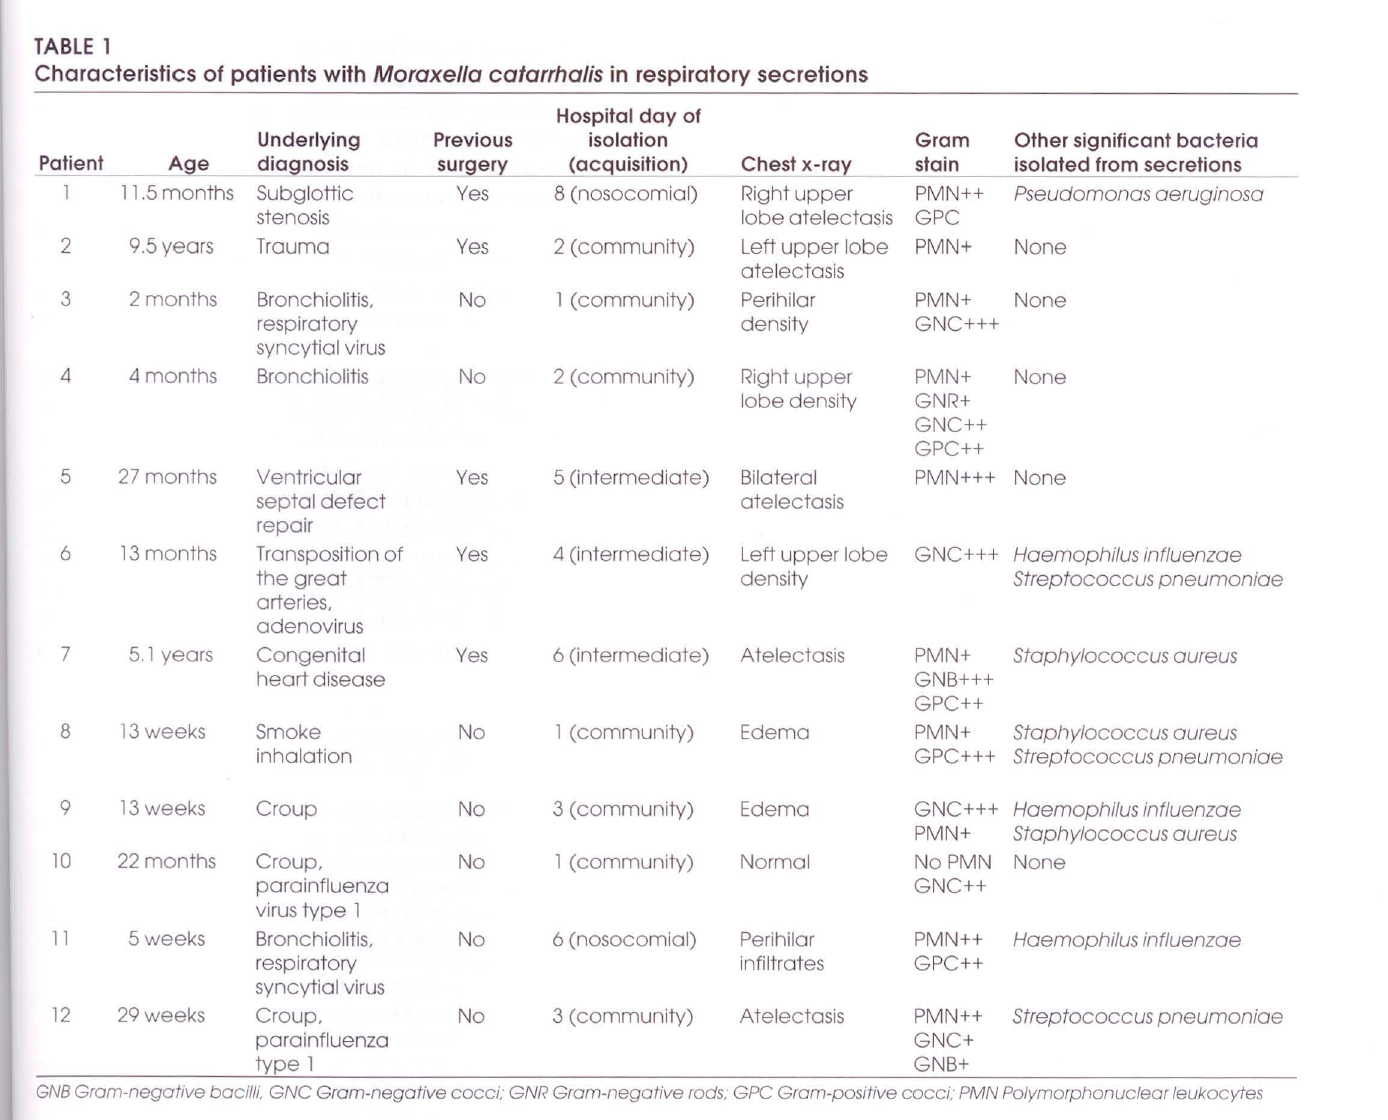
TABLE 1 Characteristics of patients with Moraxel/a catarrhalis in respiratory secretions